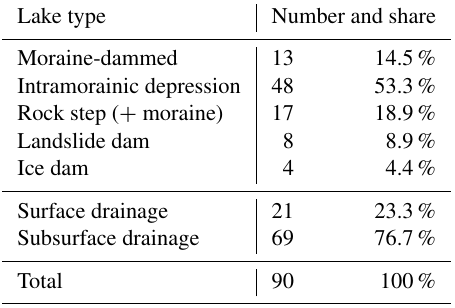
Table 1. Representation of different lake types in Kyrgyz Ala-Too, northern Tien Shan, in 2017. Only lakes with a minimum area of 1500m 2 were categorised. Based on manual mapping using satellite imagery in Google Earth and refined with the field data included in Erokhin and Zaginaev